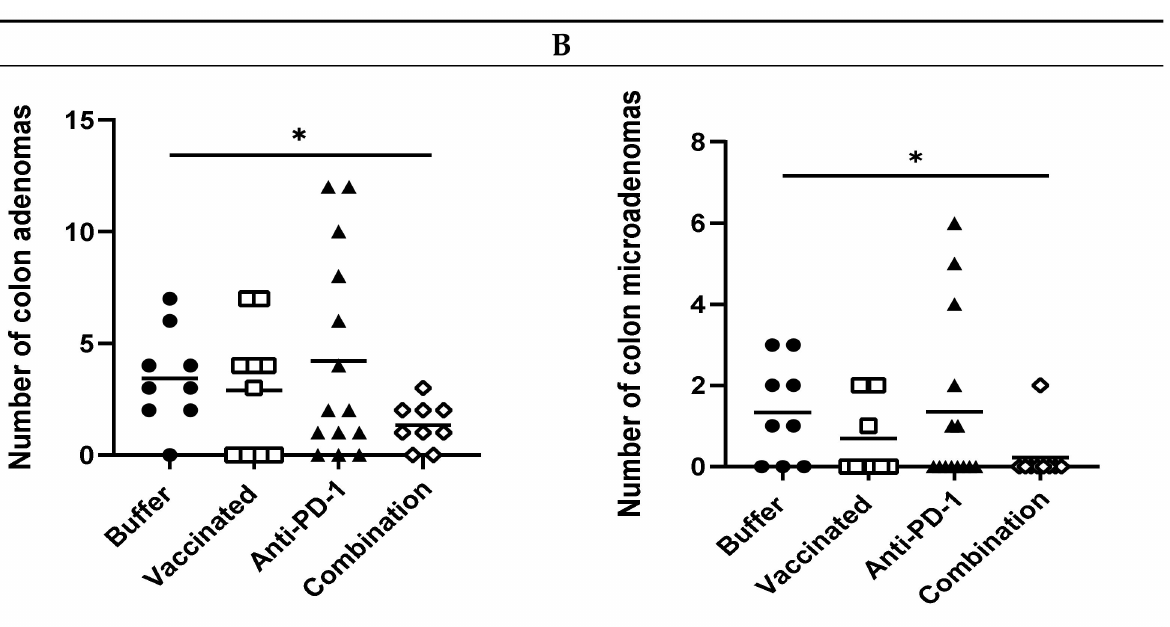
Figure 4. Efficacy of KISIMA-Mash2 vaccine and anti-PD-1 combination treatment on tumor development in Apc +/Min-FCCC mice. ( A ) Number of colon adenomas per mouse in animals that were tumor-free at treatment initiation (after removal of outliers). ( B ) Number of colon microadenomas per mouse in animals that were tumor-free at treatment initiation after removal of outliers. *, p > 0.05. All other statistical comparisons were not